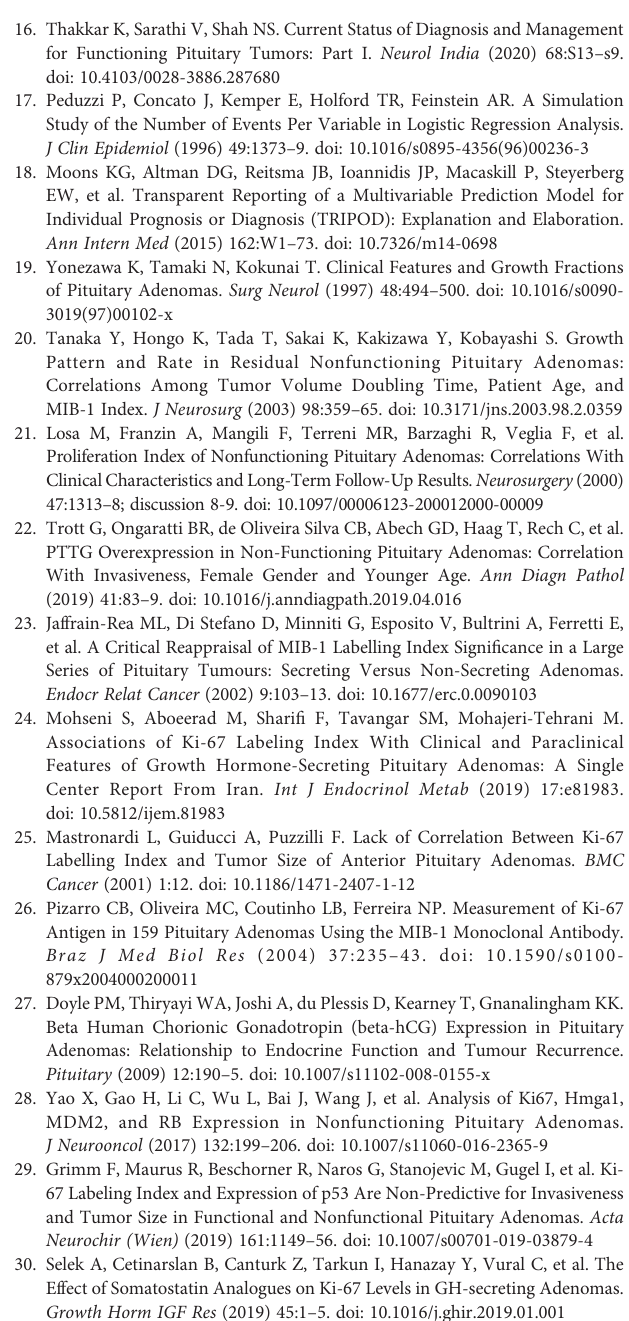
Supplementary Figure 2 | Correlation analysis. (A – C) Correlation between Ki-67 index and age (A) , maximum dimension (B) , and prolactin (C) , respectively, in all of the validation cohort. (D – G) Correlation between Ki-67 index and age in the subgroups according to nonfunctioning (D) , PRL secreting (E) , GH secreting (F) , and ACTH secreting (G) pituitary tumors. (H – N) correlation between Ki-67 index and maximum dimension in the subgroups according to microadenoma (H) , macroadenoma (I) , giant adenoma (J) , nonfunctioning (K) , PRL secreting (L) , GH secreting (M) , and ACTH secreting (N) pituitary tumors. (O – P) correlation between Ki-67 index and prolactin in the subgroups according to prolactinoma (O) and no prolactinoma (P)